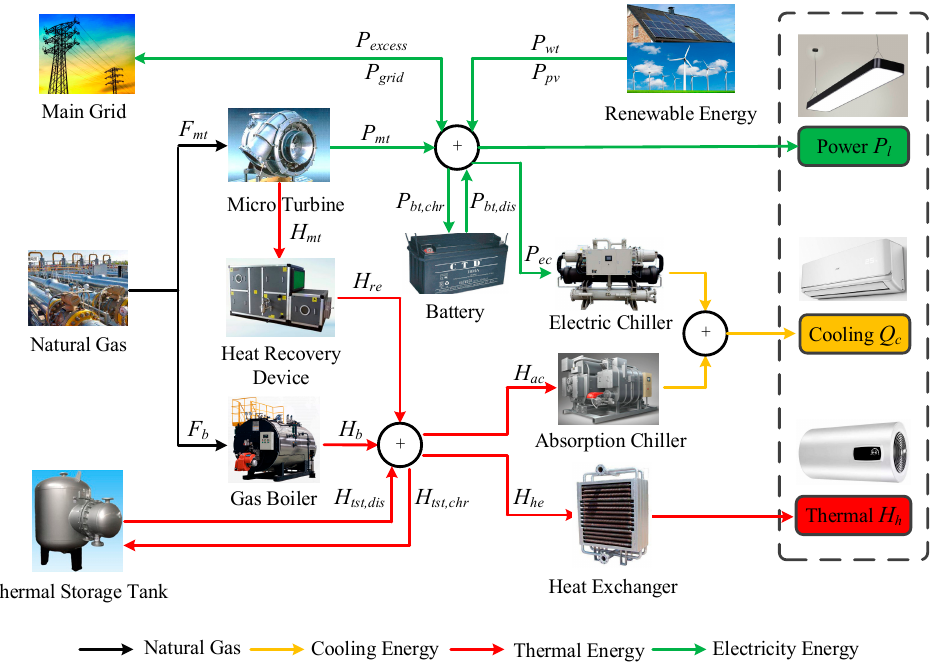
Figure 1. A structural diagram of a CCHP (combined cooling, heating, and power) microgrid.